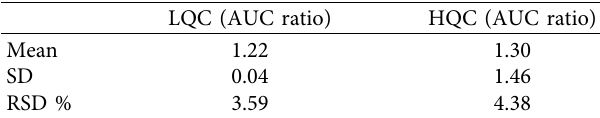
Table 5: Matrix effect of vardenafil in plasma.